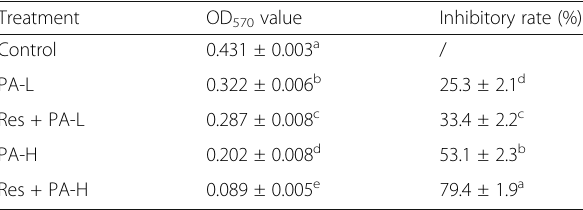
Table 2 Growth inhibitory effects of HepG2 human liver cancer cells by resveratrol and paclitaxel by an MTT Treatment